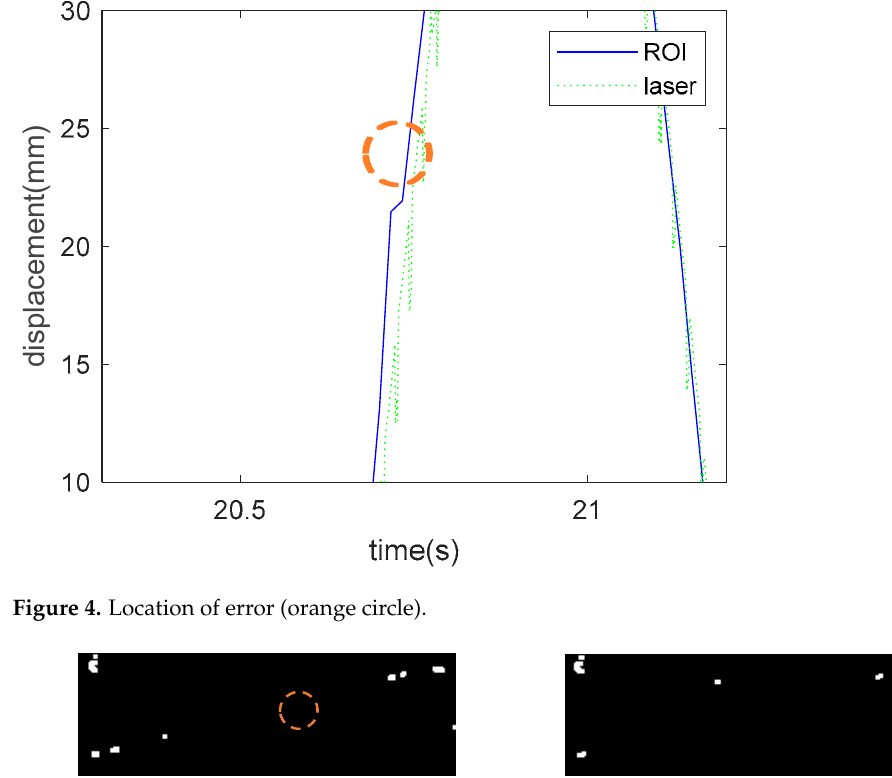
Figure 4. Location of error (orange circle).